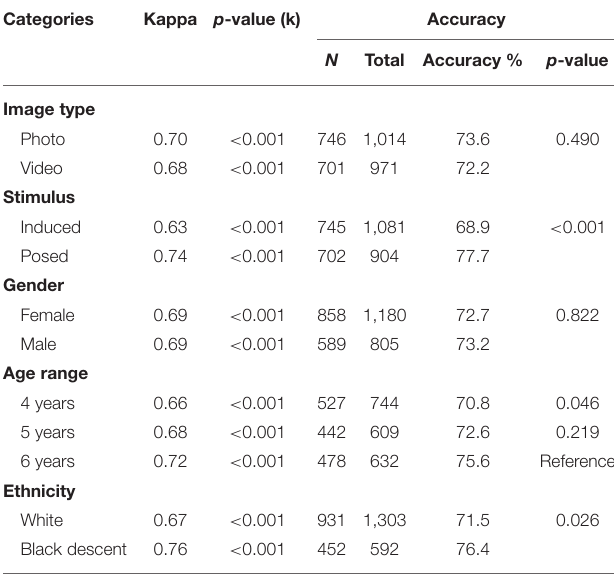
TABLE 2 | Agreement between judges 3 and 4 regarding facial expressions of different emotions according to image type, stimulus, gender, age and ethnicity.